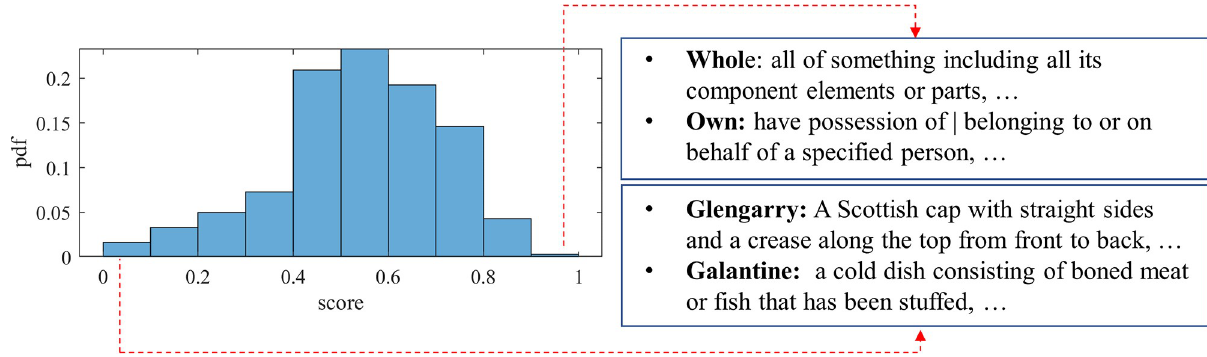
Fig 9. Vocabulary task: Distribution of the average BLEU score of different stimuli. Some examples with very high and low scores are also provided on the right, from references.